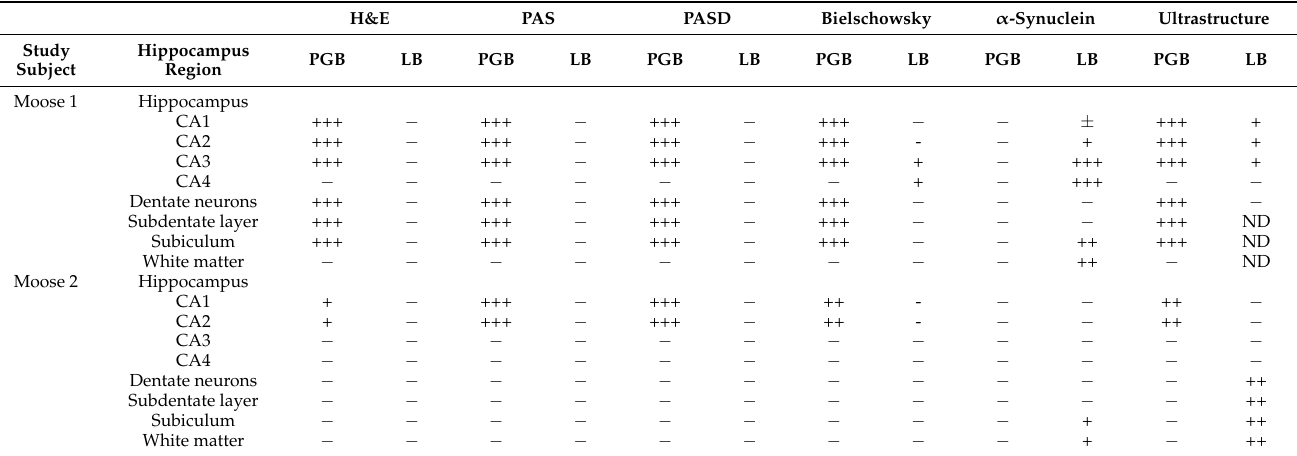
Table 1. Lesions with severity in various regions of the hippocampus identified in light and electron microscopy.